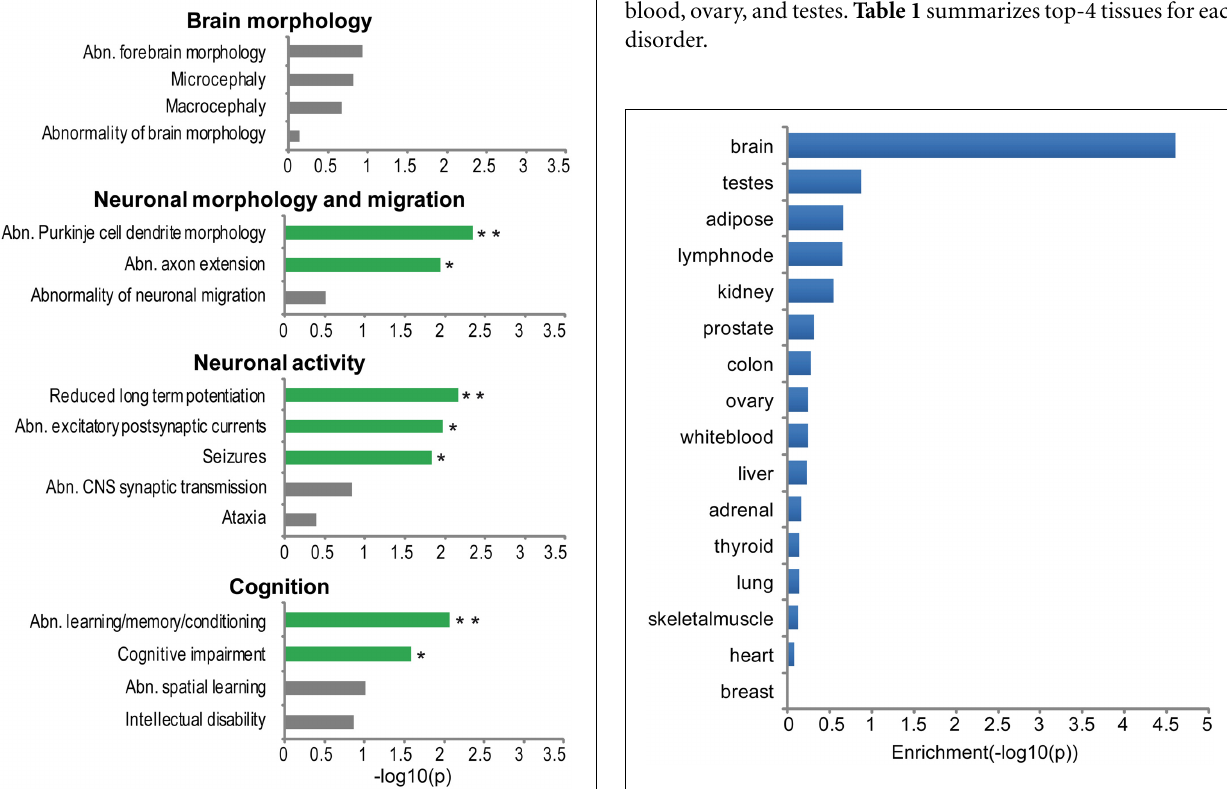
FIGURE 2 | Phenotype enrichment. − log 10 ( p -value) of cross-species phenotypes from Uberpheno grouped to broader categories. Significant terms are depicted in green; ∗∗ p < 0 . 01, ∗ p < 0 . 05.